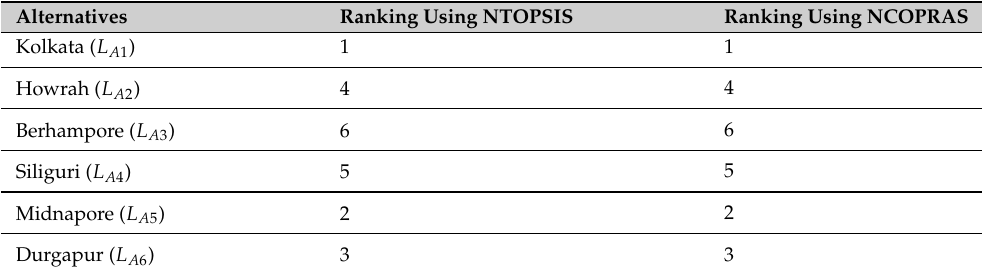
Figure 7. Depiction of ranking alternatives by removing Investment Cost ( ˜ m 2 ) . Table 20. Ranking alternatives by removing Investment Cost ( ˜ m 2 )